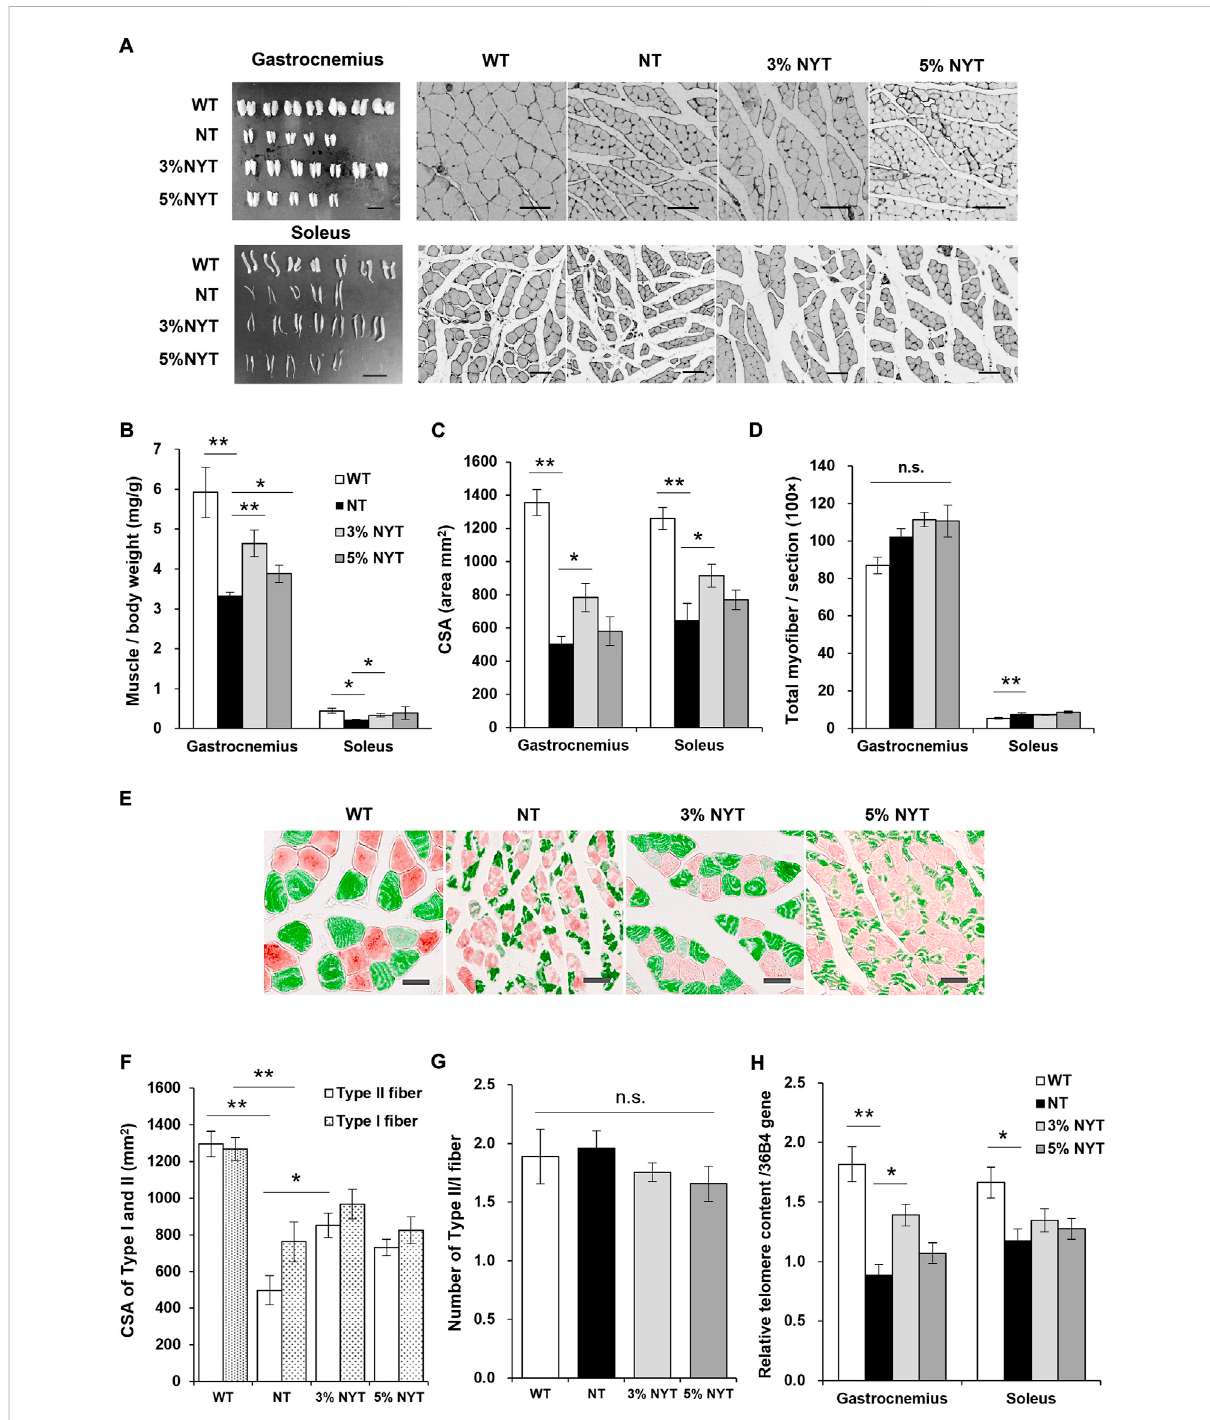
FIGURE 6 Effect of NYT on atrophy of fast myo fi ber fi ber and its aging. The dissected triceps muscle, consisting of the gastrocnemius ( A , upper left) and soleus muscles ( A , lower left) and its wet weight (B) in 59 days, and histological immuno-staining (dystrophin) of muscle fi bers ( A , right) are shown, scale bar indicated 10 mm (left) and 50 μ m (right). The CSA (C) and total count of myo fi ber of each muscle section (D) is shown. Images of fast type myo fi ber (green) and slow type myo fi ber (red) of soleus muscle stained by immunohistochemistry are shown in (E) , scale bar indicated 30 μ m. TheCSA offasttypeor slowtypemyo fi ber (F) andtotalcountofeach myo fi ber (G) isshown. Relativetelomerecontent ofgastrocnemiusandsoleus muscles was measured using qPCR (H) . Data are plotted as mean and SEM values. Signi fi cant differences are presented on histograms: (* p < 0.05, ** p < 0.01, Steel test (B) and Dunnett ’ s contrast (C – H) , WT ( n = 7), NT (5), 3%NYT (7), 5%NYT